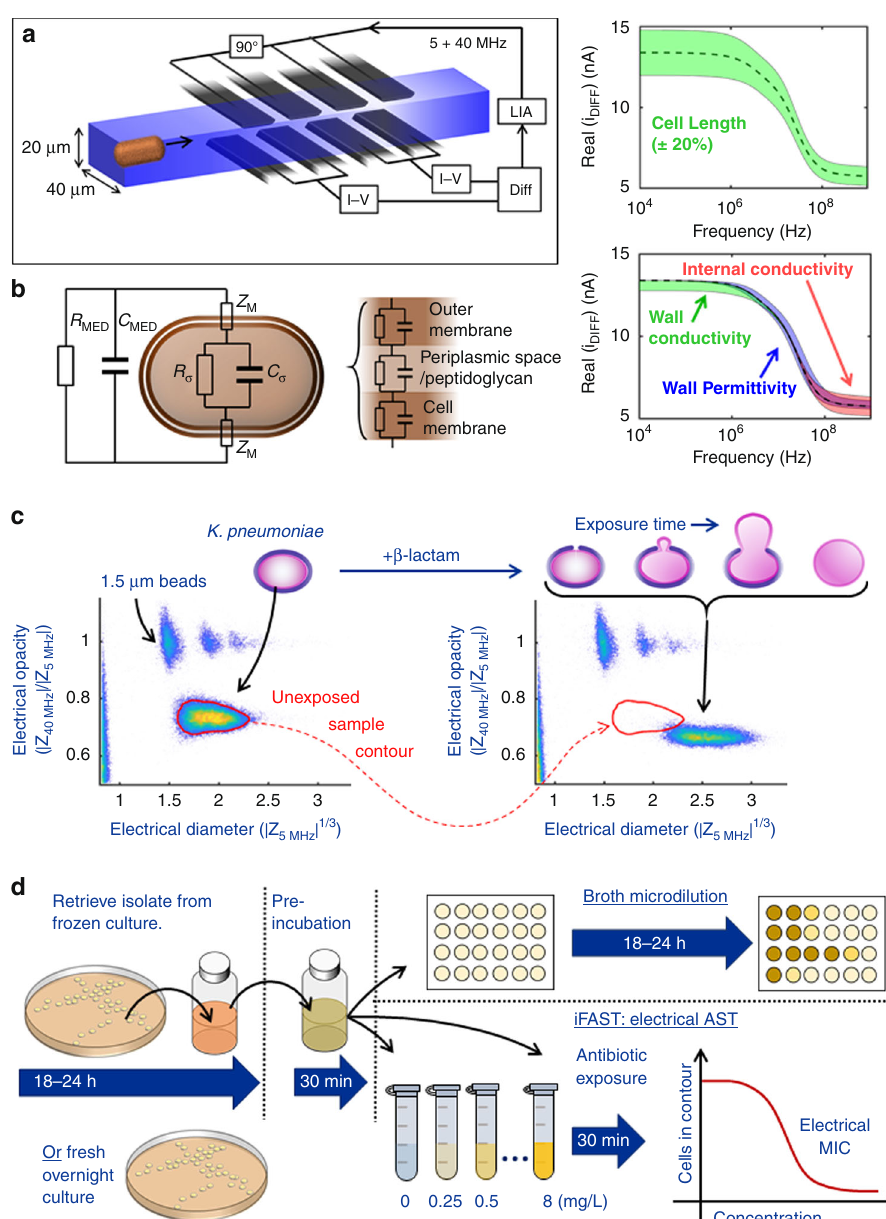
Fig. 1 Principle of rapid impedance-based antimicrobial susceptibility testing. a Multi-electrode micro fl uidic impedance chip. Cells fl ow one-by-one between sets of electrodes and are measured simultaneously at two frequencies using a lock-in-ampli fi er (LIA). b Equivalent electrical equivalent circuit model for a Gram-negative bacteria, and a simulated spectrum of the Real part of the impedance vs. frequency highlighting frequency windows where changes in cell properties become apparent. c Impedance scatter plot of bacteria ( K. pneumoniae , 10,000 events) together with 1.5- μ m diameter polystyrene beads (with doublets and triplets) that are used as reference particles. The x -axis is the cube root of the impedance (proportional to diameter) measured at a frequency of 5 MHz. The y -axis is the electrical opacity, a measure of membrane/cell wall properties normalised to cell volume. This is measured at 40 MHz where the electrical properties of the cell wall and membrane are most apparent (see b ). Two data sets are pre- and post-exposure to Meropenem at the clinical breakpoint for 30 min at 37 °C. In the scatter plot, the red contour de fi nes the initial cell population. The diagram illustrates the change in cell properties following exposure to a β -lactam antibiotic as the cell wall breaks down (reduction in opacity) and the bacteria swell (increase in volume). d Experimental methodology for the impedance-based Fast Antimicrobial Susceptibility Test (iFAST). An actively dividing culture is prepared and incubated for 30 min with antibiotics. Polystyrene beads are added and the sample is measured for 3 min to determine the electrical MIC (see Supplementary information for further